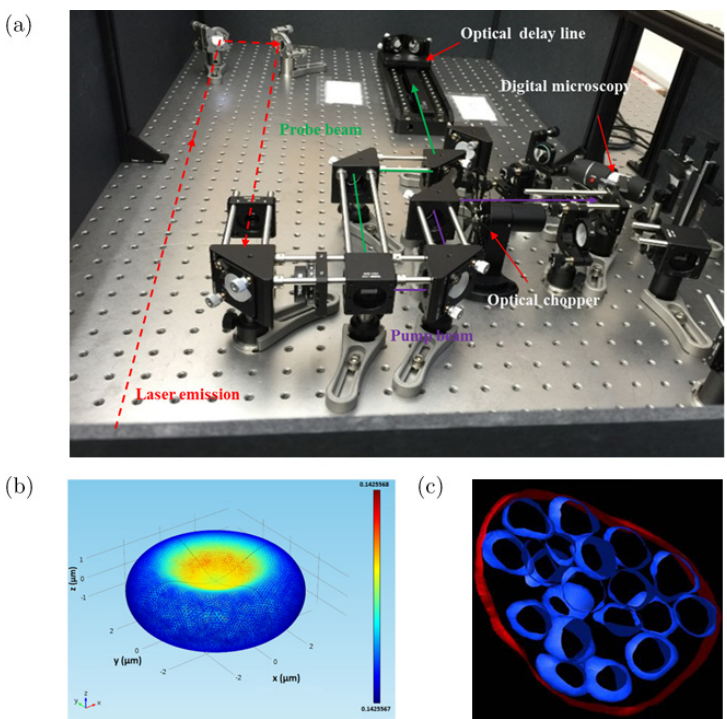
Fig. 4. (a) nPAT System setup. Pump-probe technique is used to provide ultra-high frequency detection. (b) Spatial distribution of temperature rise on a single regular biconcave red blood cell (Fig. 6 of Ref. 32). (c) 3D nPAT imaging reconstruction of malarial parasite invasion (in blue) of human erythrocytes (in red), where the biconcave shape is no longer